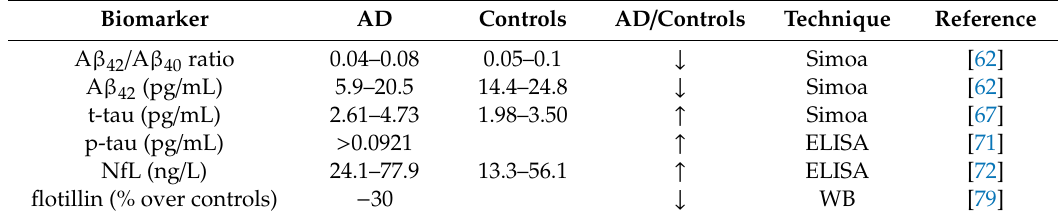
Table 2. Changes in levels of blood biomarkers in AD patients and